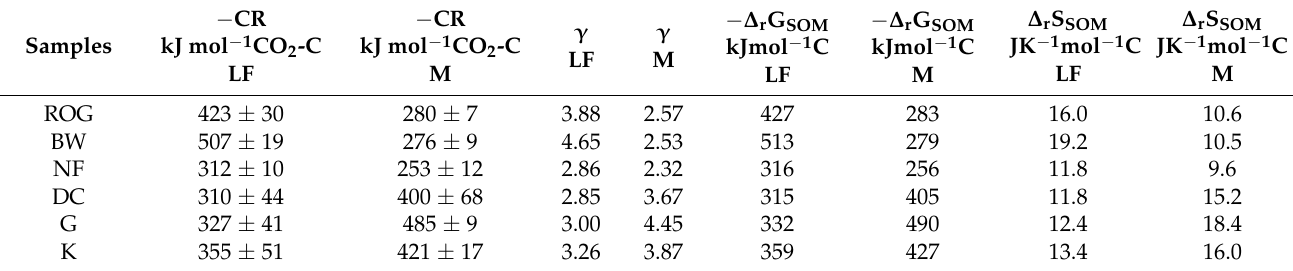
Table 4. Values for the calorespirometric ratio, CR, for the LF and M samples from the UK (ROG, BW, and NF) and Ireland (DC, G, and K); the degree of reduction of substrates being metabolized, γ r , is obtained By Equation (5). Assuming CR represents the enthalpy change of Reaction (4), ∆ r H SOM ; Gibbs energy change for Reaction (4) is also obtained by Sandler and Orbey’s correlation, ∆ r G SOM , as well as entropy change for Reaction (4), obtained by Equation (3), ∆ r S SOM. . Uncertainties for the degree of reduction and Gibbs energy change estimated from Sandler and Orbey’s correlation are the same as reported in Tables 2 and 3. Standard deviation in CR samples is determined from two replicates of each sample.